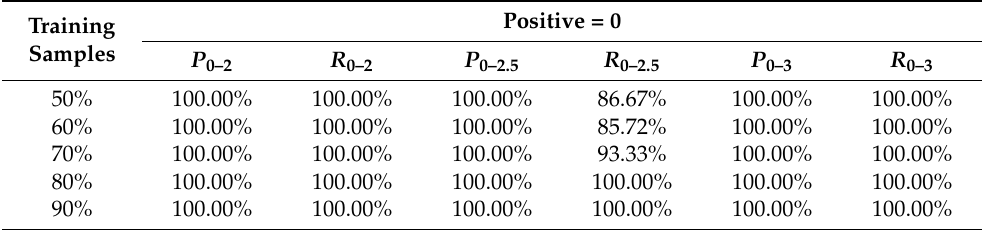
Figure 7. The confusion matrix of the test results with 50–80% (confusion matrix ( a – d )) of the samples. The results for the inter-class precision and recall ratio when the training set samples accounted for 50%, 60%, 70%, 80%, and 90% are shown in Tables 4–7. Table 4. Inter-class precision and recall of Co as positive.